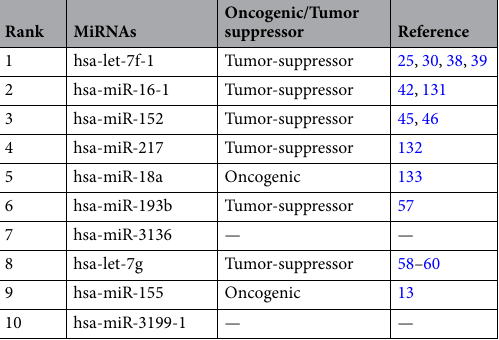
Table 4. Role of the top-10 miRNAs in lung